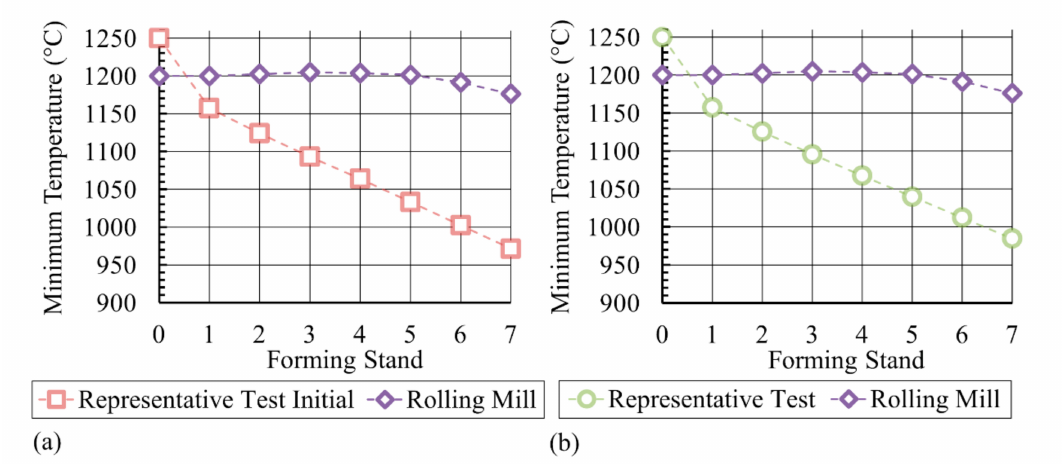
Figure 7. Comparison between the temperature calculated at the centre of the sample for ( a ) the initial representative test configuration and the rolling mill and ( b ) for the corrected representative test configuration and the rolling mill.